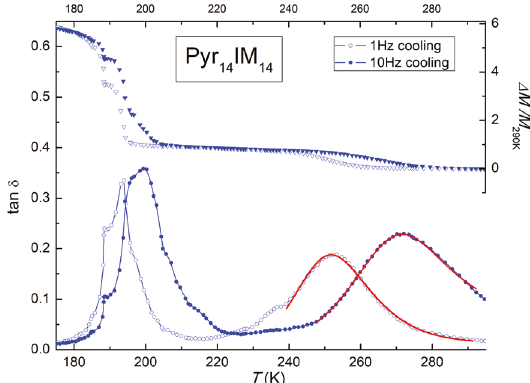
-IM , measured 14 14